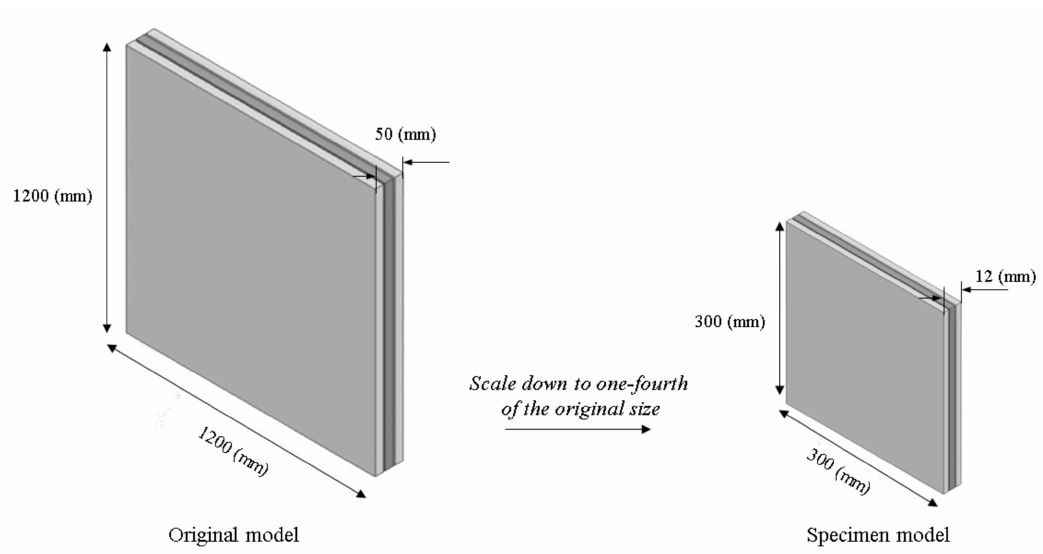
Figure 4. 3DP CCW specimen